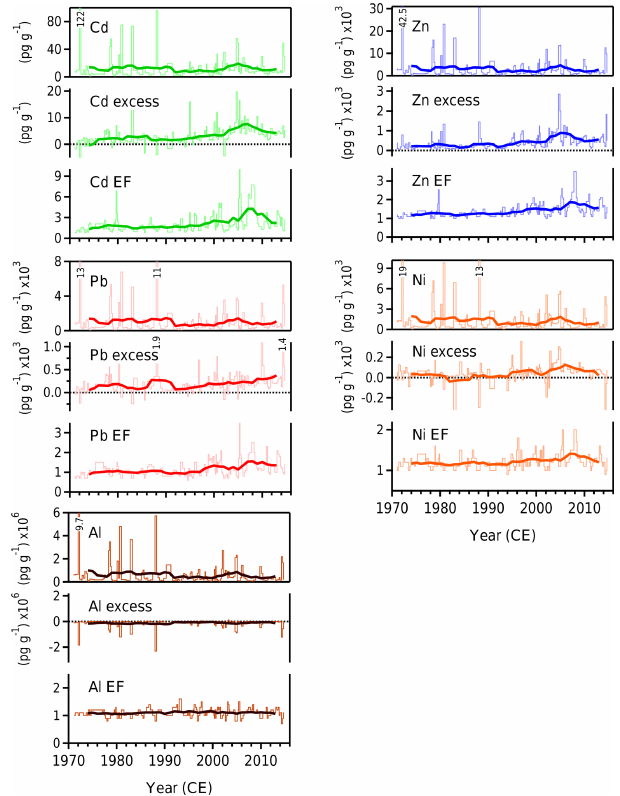
Figure 2. Cd, Pb, Zn, Ni, and Al 5-year running means (thick lines) of concentrations, excess concentrations, and EFs between 1971 and 2015. Thin lines show the sample resolution.